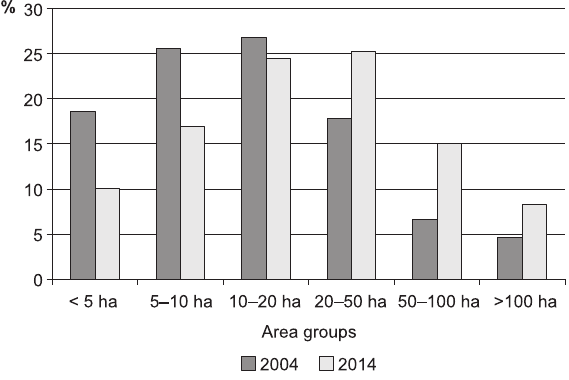
Fig. 10. Average size of organic farms in Poland by voivodeship, 2014. Source: own calculations based on the IJhArS